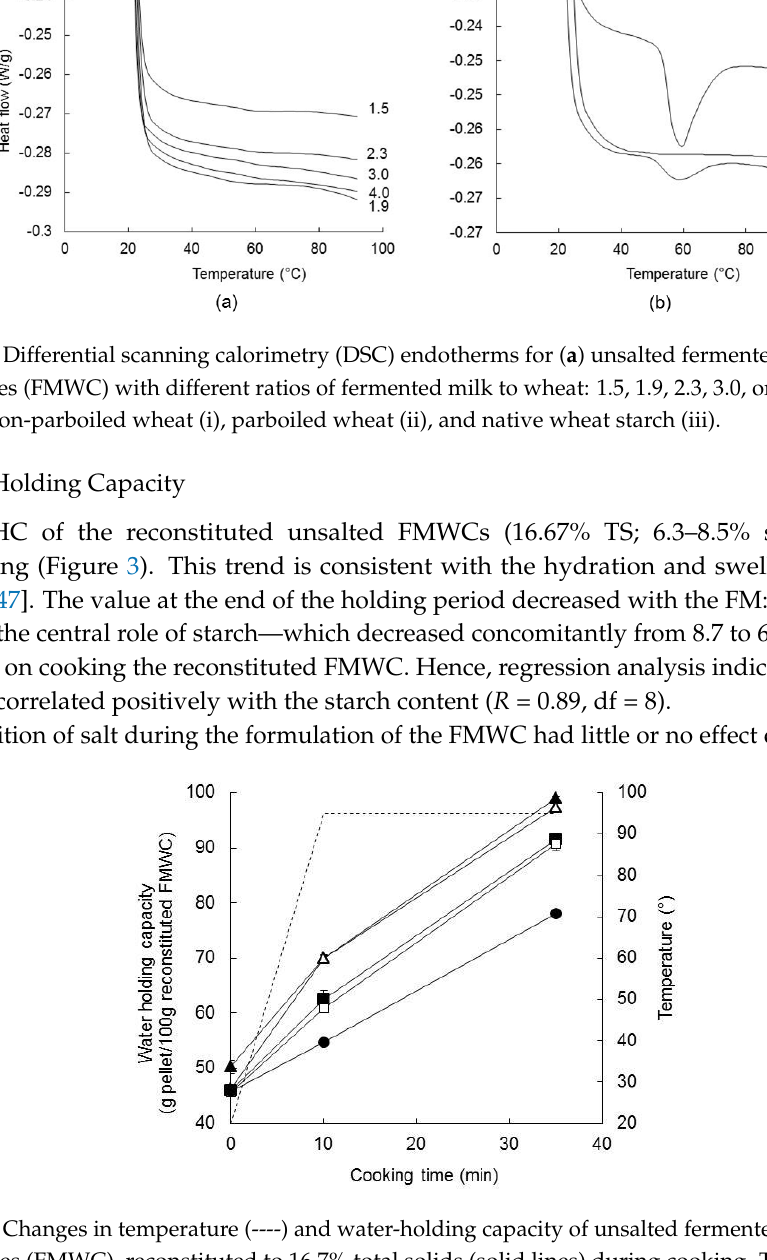
wheat composites (FMWC), reconstituted to 16.7% total solids (solid lines) during cooking. The